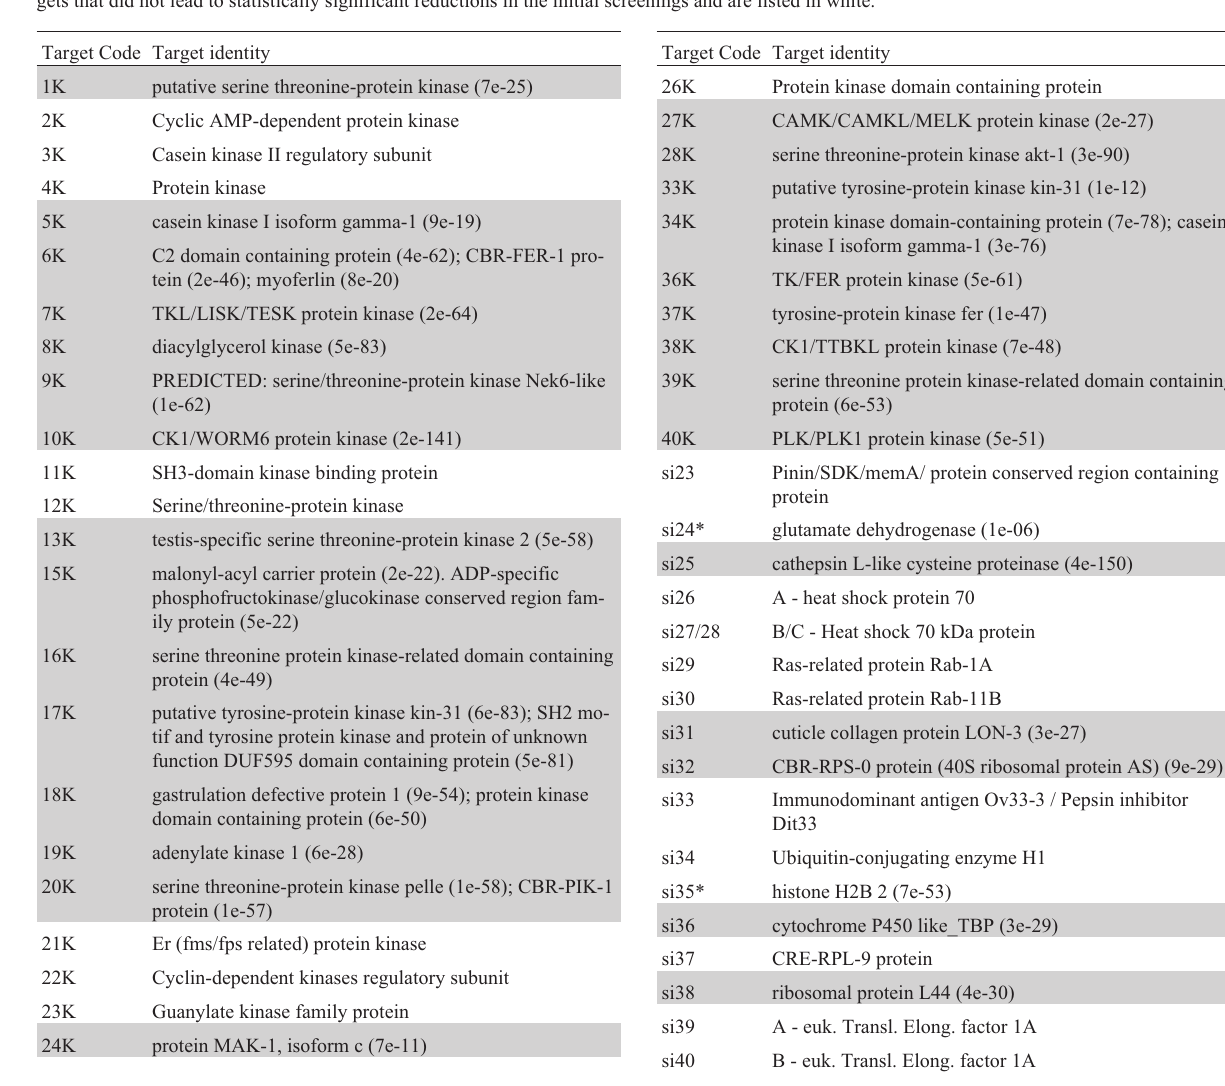
Table1 -Functionalidentificationofanhydrobiosis-relatedgenesviaRNAi.Allthe40geneswhoseknockdownleadtostatisticallysignificantdecreases in survival percentage (cid:5) 10% compared to control group ( i.e. , worms soaked with RNA duplexes against GFP, normalized as 100% survival) are listed here in gray. Nine genes (marked with asterisks) presented statistically significant decreases lower than 10% (One-Way ANOVA). The remaining 48 tar- gets that did not lead to statistically significant reductions in the initial screenings and are listed in